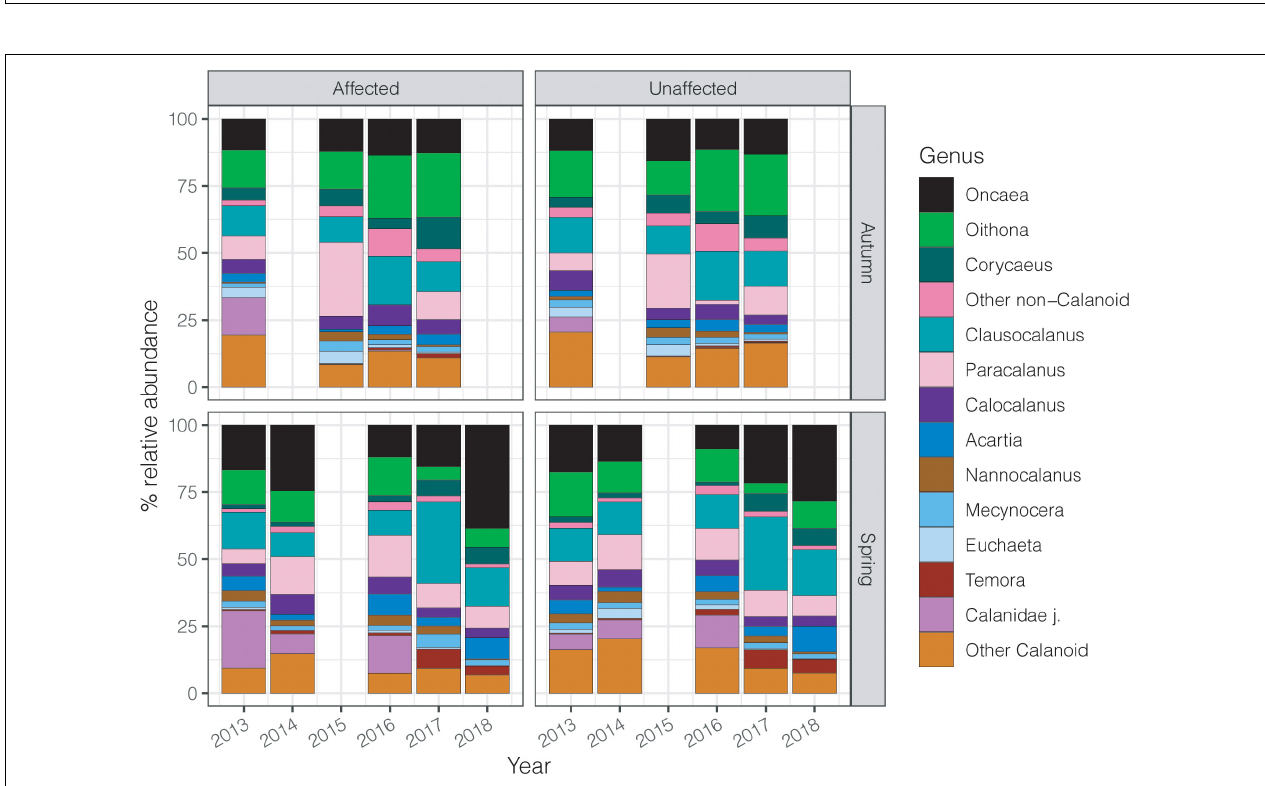
FIGURE 6 | Contribution (%) of the dominant copepod genera to each survey over the six studied years, considering spring and autumn in the affected and unaffected stations.